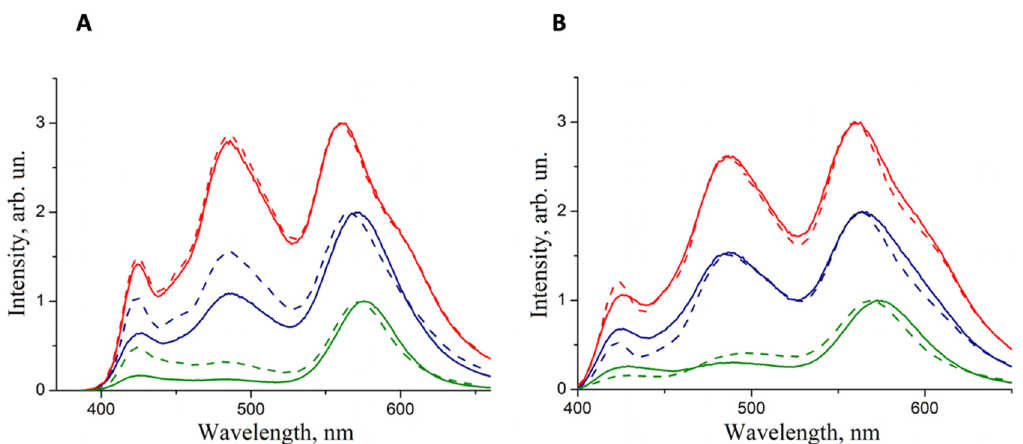
Figure 6. Luminescence spectra of composites consisting of QDs with OXDhexSH ligands and p99 ( A ) and QDs with NIhexSH ligands and p99 ( B ) recorded immediately after composite preparation (solid lines) and after a week of storage under normal conditions (dashed lines). The QD-to-polymer mass ratios in the composites were 1:10 (red lines), 1: 1 (blue lines), and 5: 1 (green lines).